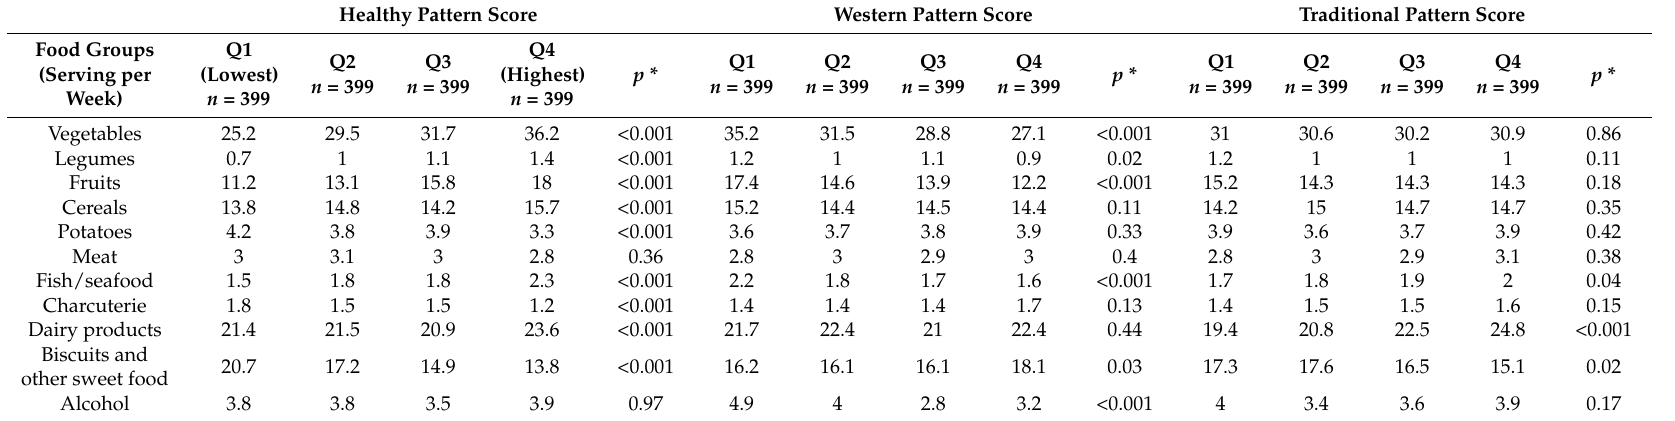
Table 4. Mean food group intakes according to quartiles of component scores obtained by factor analysis—principal component analysis of nutrient intake data in NuAge ( n = 1596), from food frequency